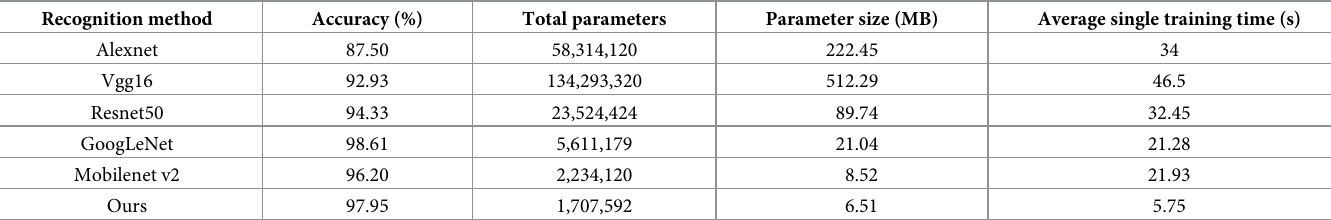
Table 2. Analysis of the results of different